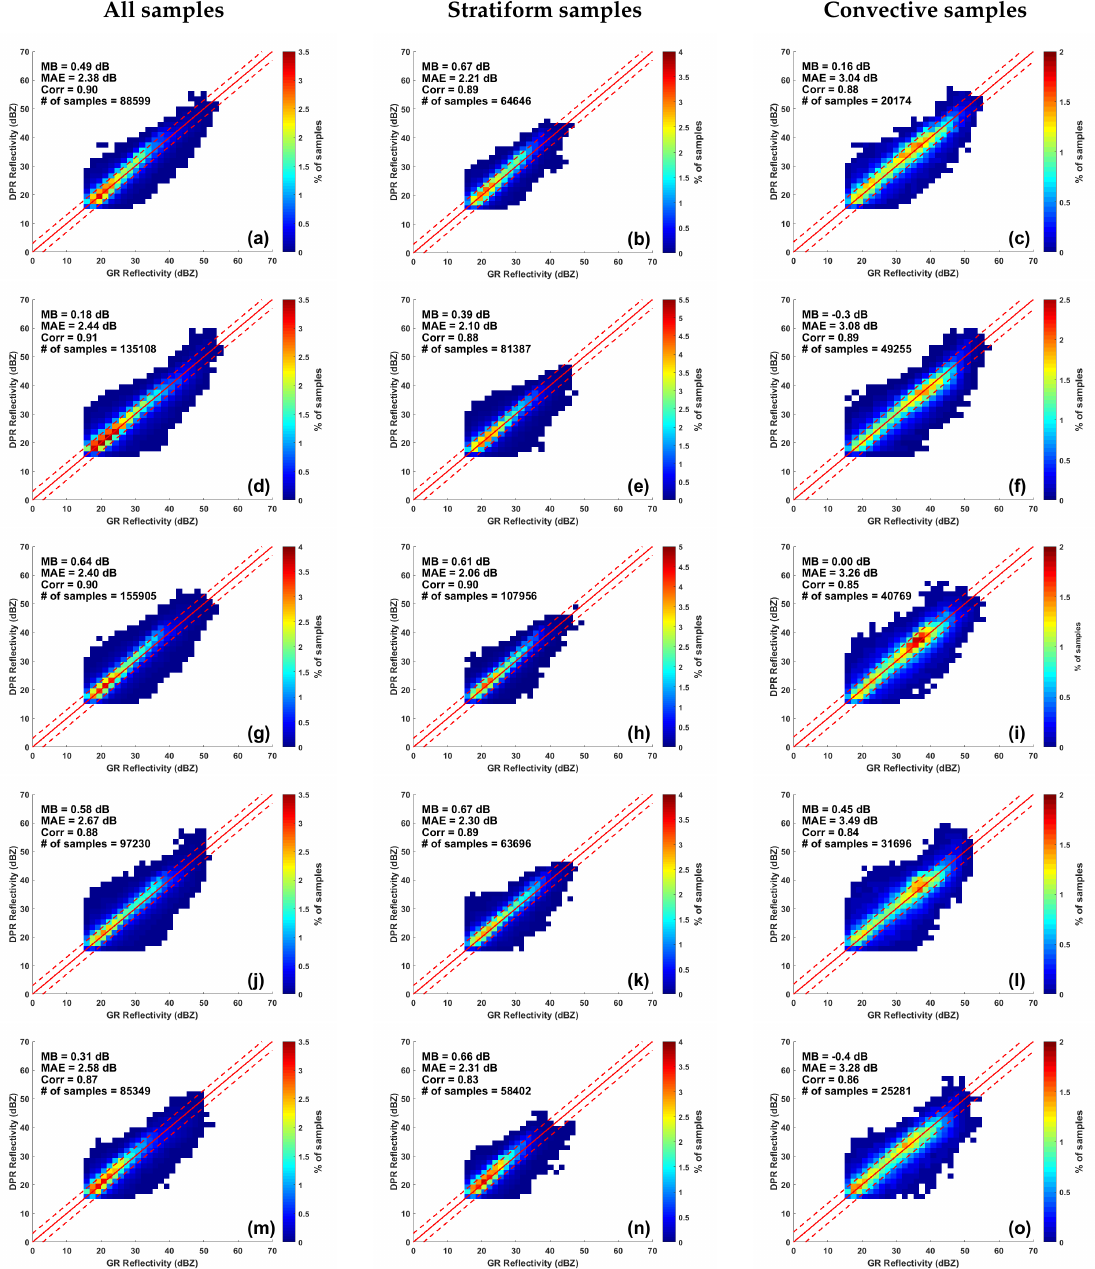
Figure 4. Scatter density plots of volume matched reflectivity between GPM-DPR Ku-Band and NEXRADs. Solid red line is 1:1 line. Dotted red lines are ± 3 dB lines. ( a – c ) KFWS radar; ( d – f ) KHGX radar; ( g – i ) KSHV radar; ( j – l ) KLIX radar; ( m – o ) KMLB